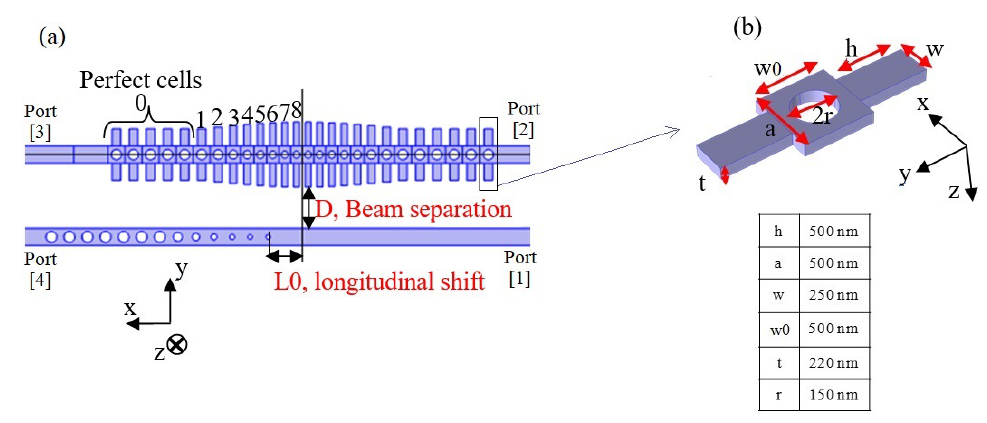
Figure 5. ( a ) Geometry of the OM cavity with tapered stubs heights. ( b ) Unit cell and geometric parameters of the unit cell in the perfect phoxonic